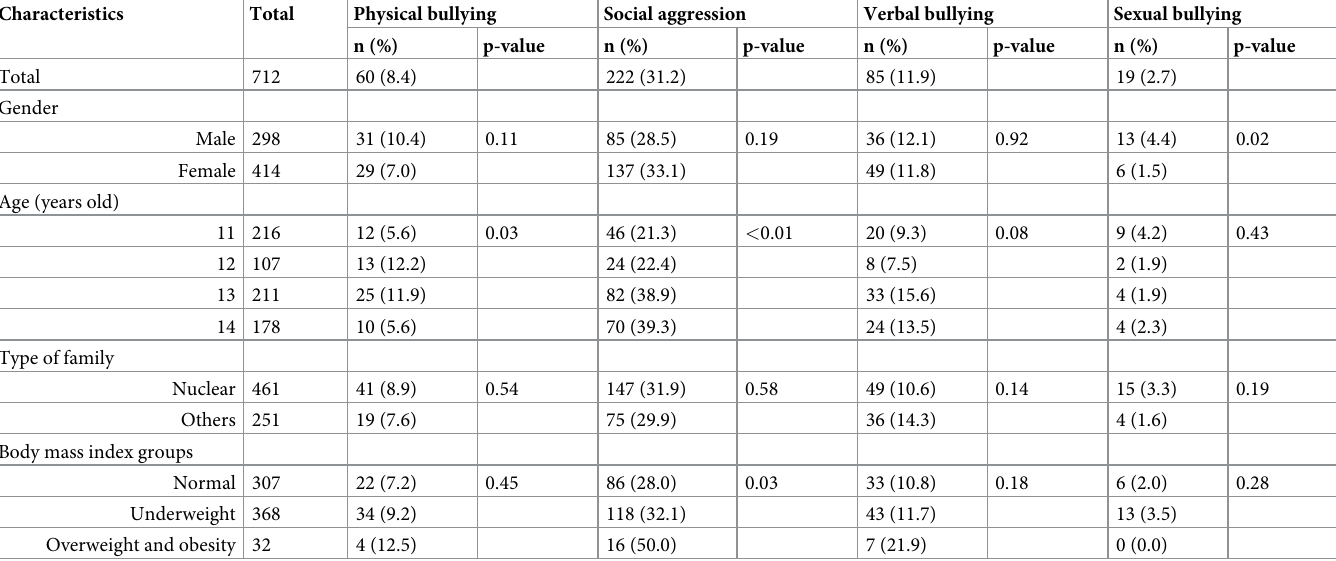
Table 1. Demographic characteristics of respondents.